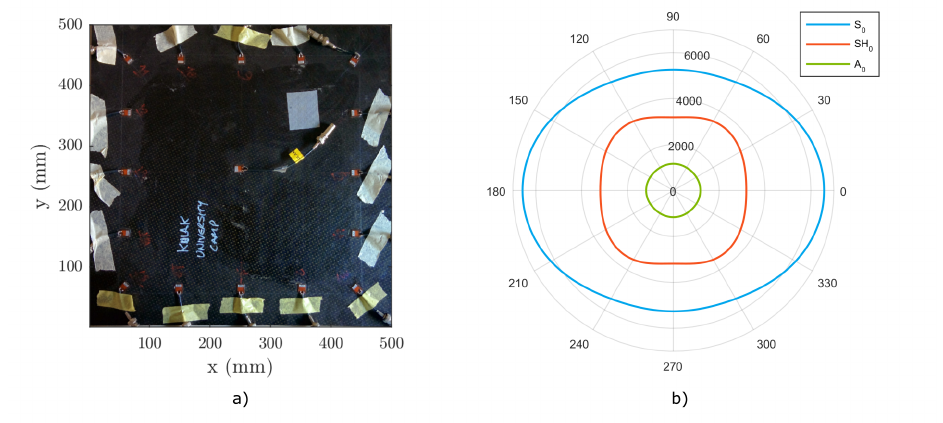
Figure 10. ( a ) CFRP plate for experimental testing; ( b ) angular dependence of the phase velocity at 50kHz for the CFRP